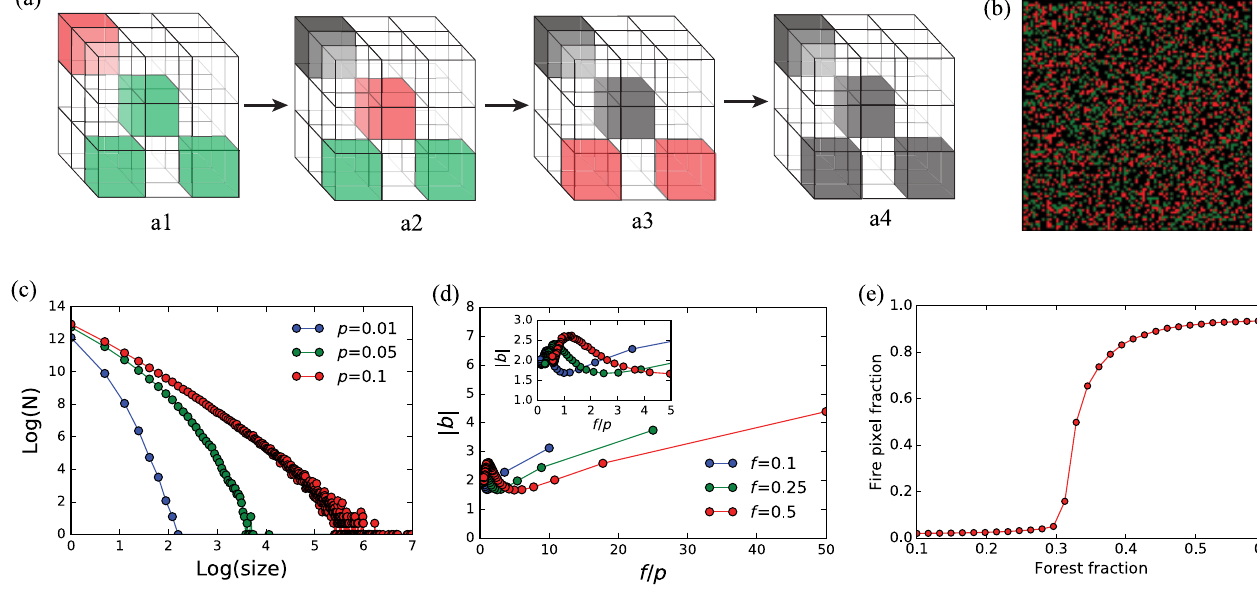
FIG. 2. Self-organization as a result of facilitated Rydberg excitation. (a) In analogy to the forest-fire model, cells in the NI phase (green) transition to the I phase (red) as neighboring cells in the I-phase Rydberg facilitate excitation [(a1) to (a2)]. Following the transition to the I phase, cells are depleted of Rydberg excitations (black) due to enhanced decay [(a2) to (a3)]. (b) Example showing phases in a single plane of a system with 100 × 100 × 100 cells following 30 iterations (here, p ¼ 0 . 3 and f ¼ 0 . 1 ). (c) Size distribution of I-phase clusters for simulations with different p . The initial fraction of the cells in the I phase is 0.5. (d) Power-law exponent j b j vs f=p for f ¼ 0 . 1 , 0.25, and 0.5. The inset shows a zoom-in for f=p < 5 . (e) The simulated I fraction vs NI fraction as a threshold near a NI fraction of 0.3. Here, the system is initially depleted in the first plane of 100 × 100